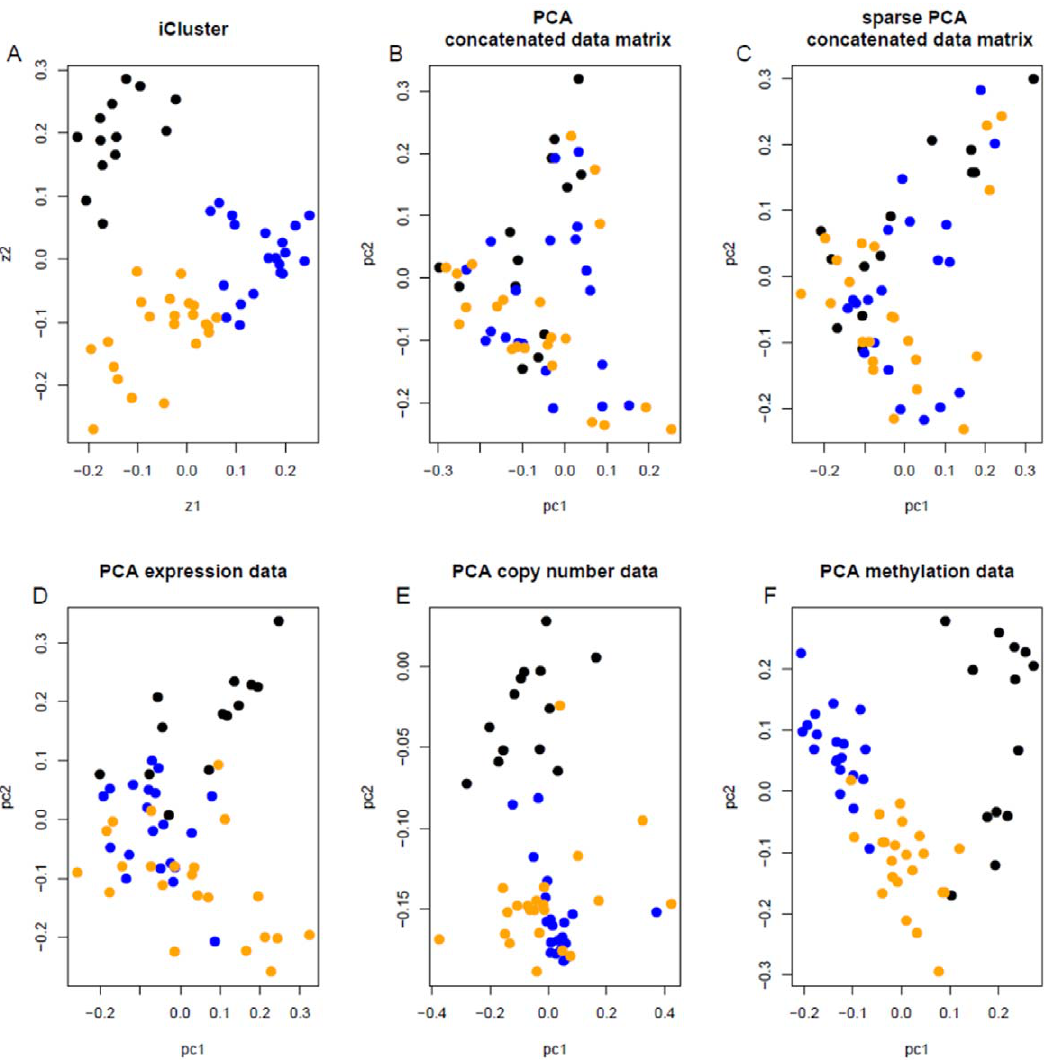
Figure 4. Comparison of the iCluster method to PCA approaches in the GBM data set. Two-dimensional plots of the sample points in the latent subspace spanned by A) the first two joint latent factors obtained using iCluster, B) the first two principal components (PCs) from the concatenated data matrix, C) the first two sparse PCs from the concatenated data matrix, D) the first two PCs from the mRNA expression data alone, E) from the copy number data alone, and F) from the methylation data alone.